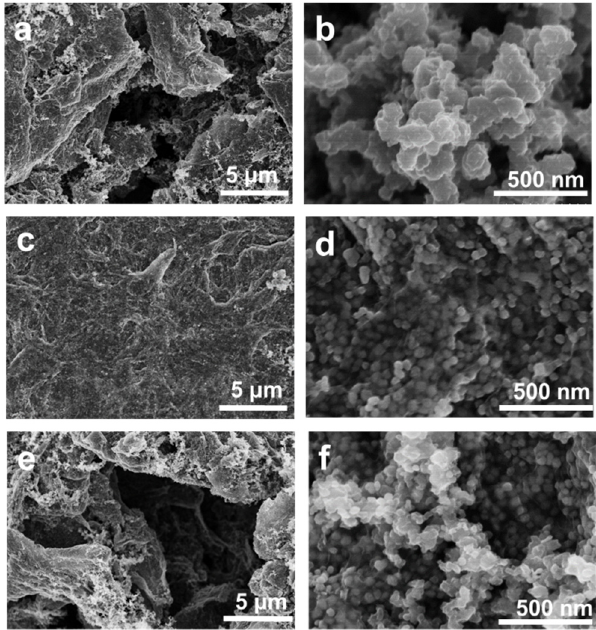
Figure 6. SEM images of the ( a , b ) Fe 2 O 3 /NG and ( c , d ) Fe 2 O 3 /Fe 3 O 4 /NG electrodes after 100 discharge- charge cycles at 1000 mA g − 1 at different magnifications. SEM images of the ( e , f ) Fe 2 O 3 /Fe 3 O 4 /NG electrodes after 300 discharge–charge cycles at 1000 mA g − 1 at different magnifications. Table 1. The fitted EIS parameters and diffusion coefficients of Fe 2 O 3 /NG and Fe 2 O 3 /Fe 3 O 4